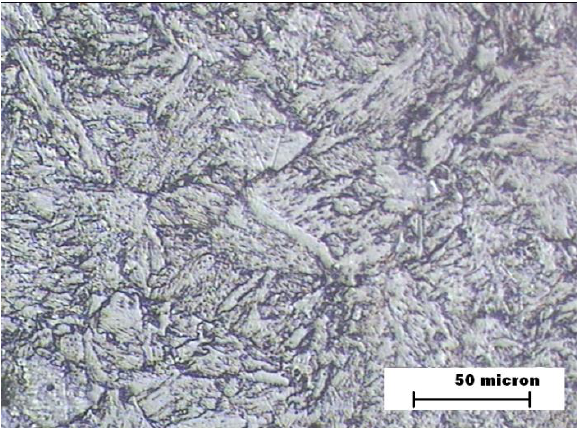
Figure 5. Sample A. Fusion zone (FZ) microstructure.